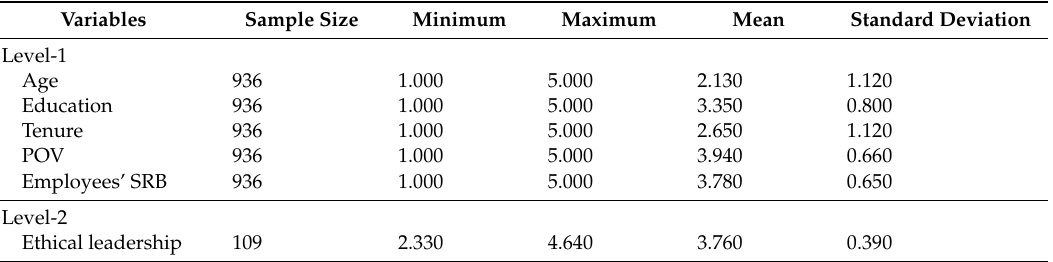
Table 4. The descriptive statistics of the